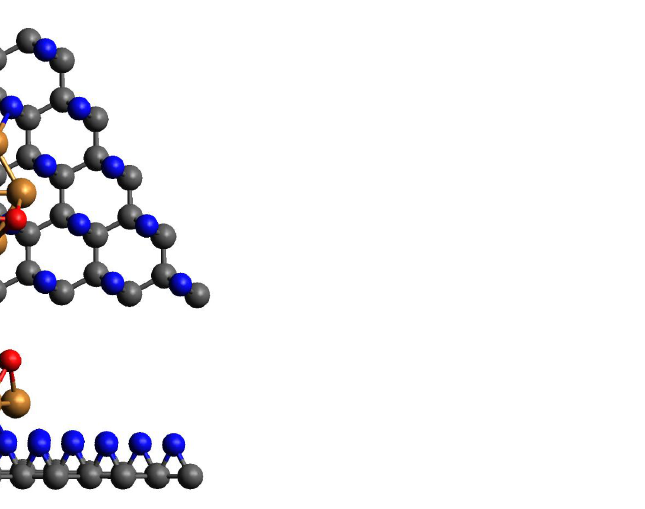
Figure 3. Schematic representation of top ( a ) and aside ( b ) views of six-faceted Cu nanopyramid deposited on N-saturated graphene monolayer. Grey balls stand for carbon atoms, orange for copper, red balls are oxygen atoms, and blue ones are nitrogen atoms.